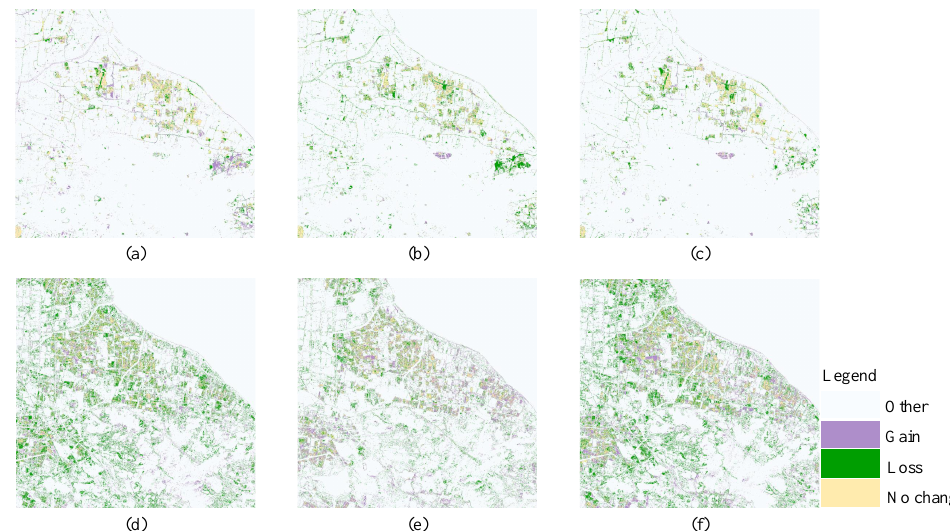
Figure 13. Dynamics of ponds in 2018–2020 ( a ), 2020–2022 ( b ), and 2018–2022 ( c ); dynamics of rice